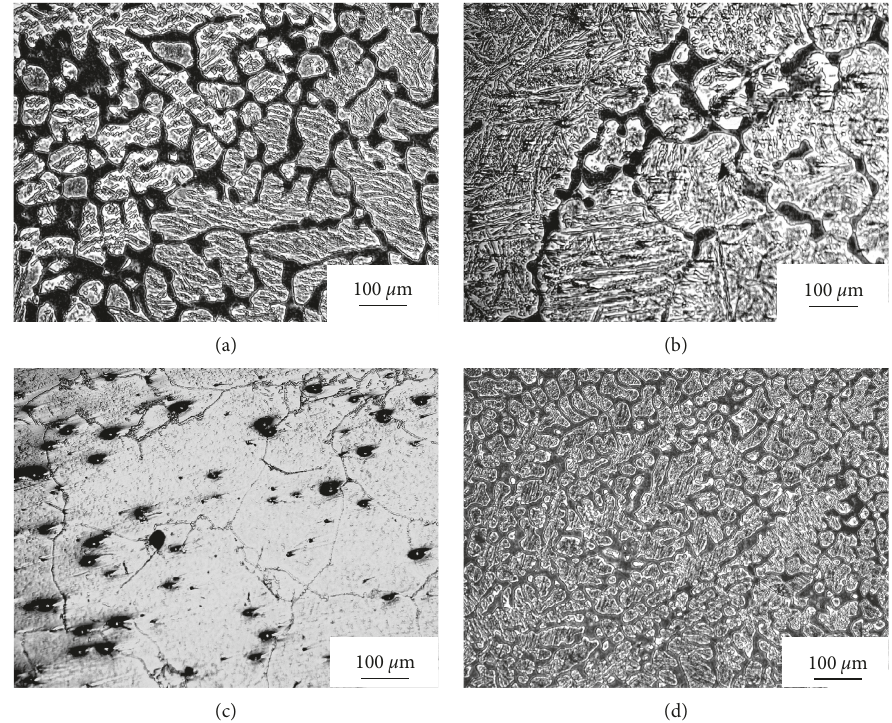
Figure 9: Micrographs of the 20 h heat-treated samples: (a) C1, (b) C2, and (c) C3 at 30mm and (d) C1 at